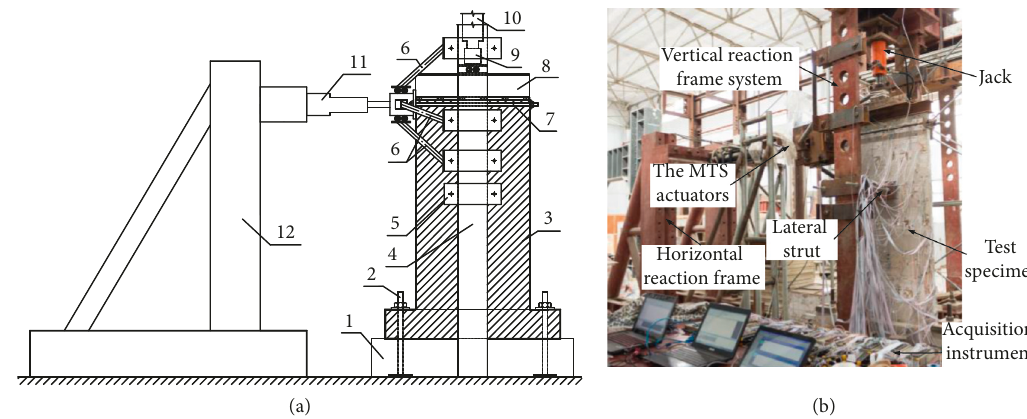
Figure 9: Test loading equipment. (a) Installation diagram. (1) Foundation; (2) sill anchor; (3) test specimen; (4) door type reaction frame; (5) lateral bracing; (6) lateral support at loading end; (7) round steel clamp; (8) vertical force distribution beam; (9) load transducer; (10) jack; (11) the MTS actuators; (12) triangular counter frame. (b) Picture of real